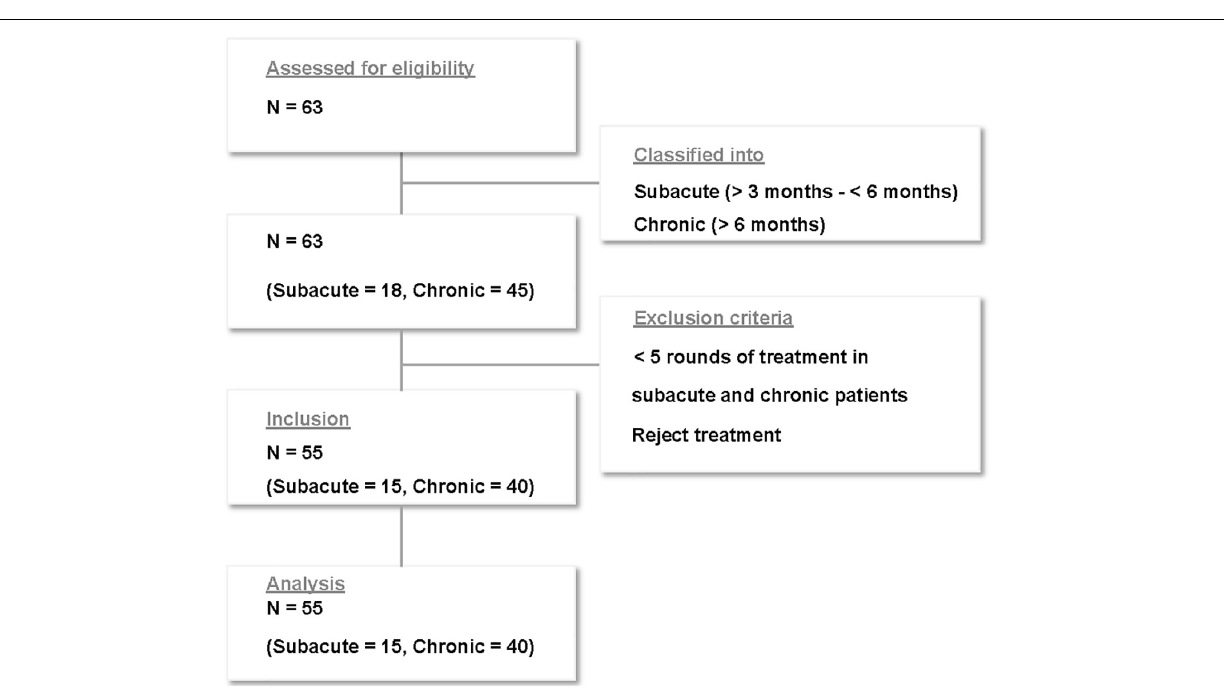
FIGURE 2 | Flow chart of patient